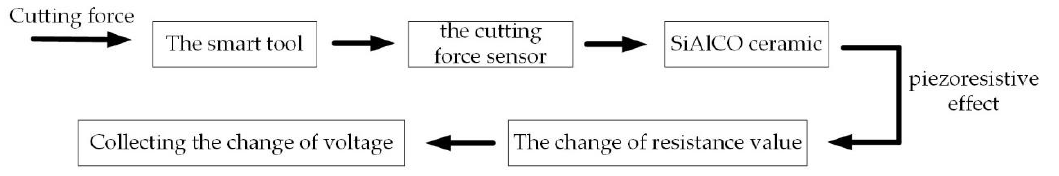
Figure 2. The working principle of the cutting force measurement.